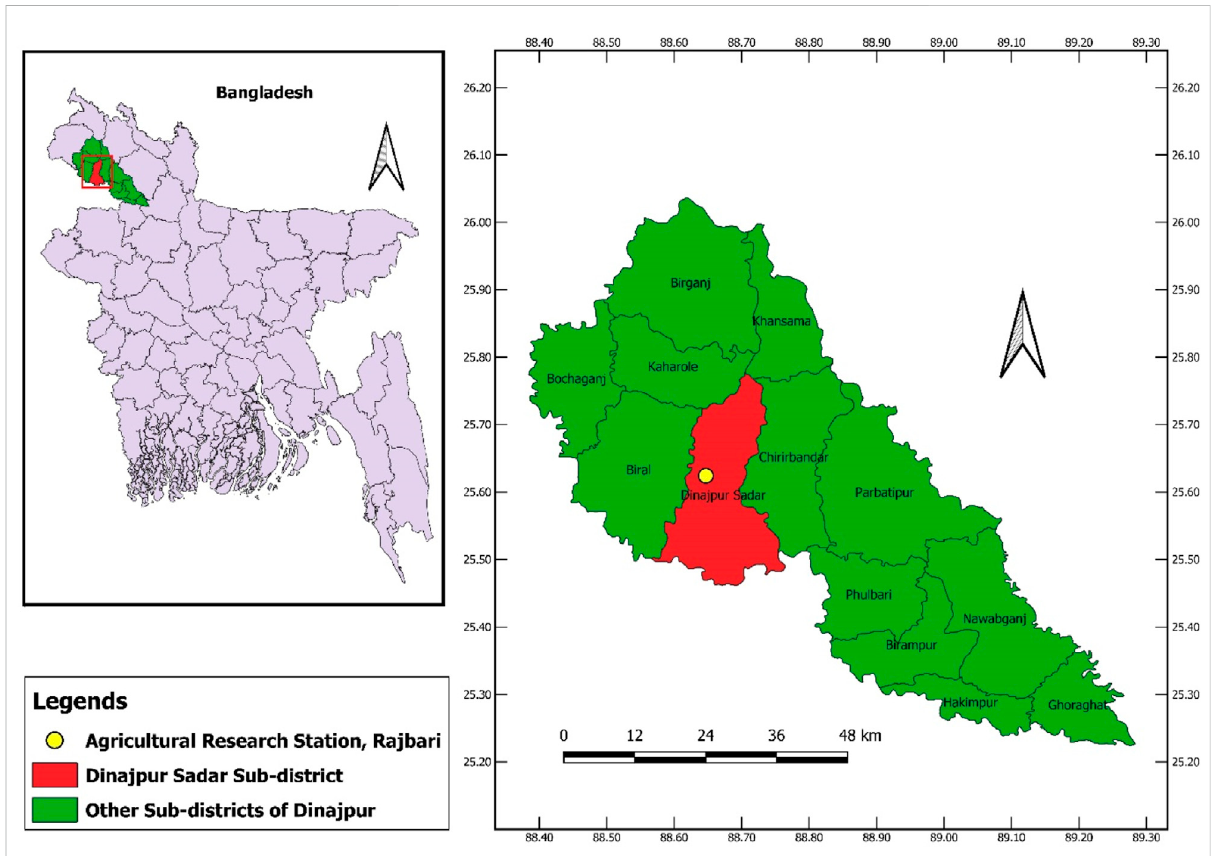
FIGURE 1 ThewholegreenhighlightedareasrepresenttheexperimentaldistrictandtheredareasrepresenttheDinajpurSadarSub-districtonthemapof Bangladesh. The yellow point is the location of the experimental site.